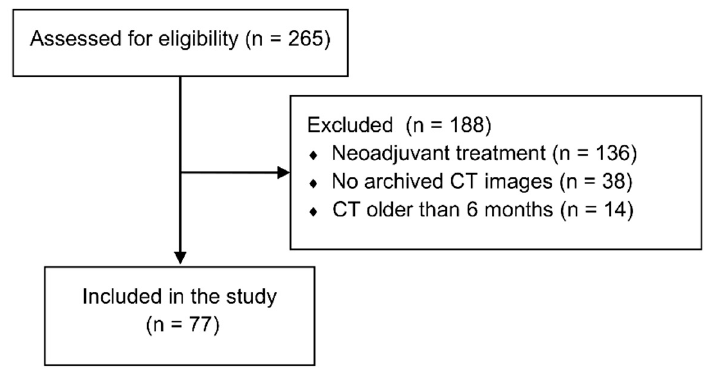
Figure 1. Study Figure 1. Study flowchart.